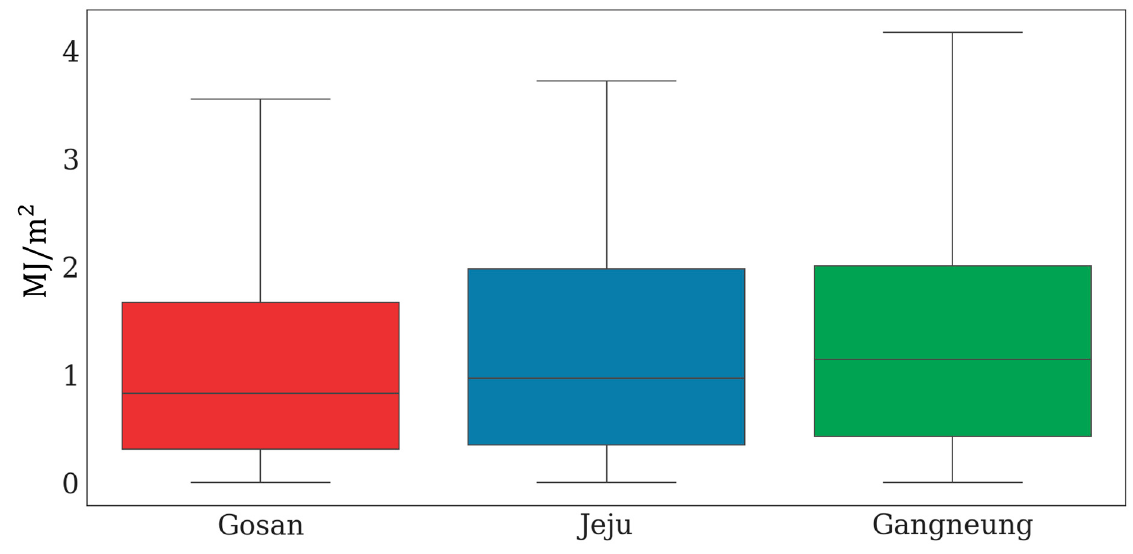
Figure 7. Box plots by region (MJ/m 2 ). Table 2. Statistical analysis of the solar radiation data by region (MJ/m 2